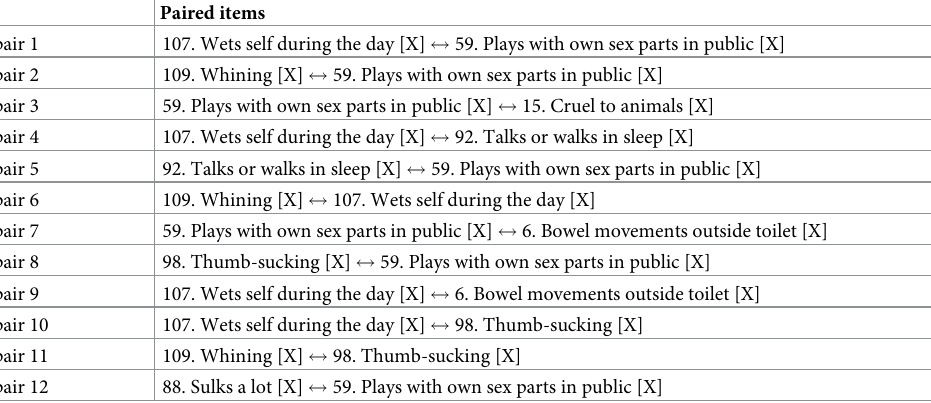
Table 2. Twelve item-item pairs are showing the most significant differences in Jaccard similarity between the CBCL and YSR. [] indicates syndromes that the items belong to. [X] indicates that the item is not a member of any par- ticular syndrome. For all pairs, the YSR showed high similarity (mean 0.963), while the CBCL showed low similarity (mean 0.014).